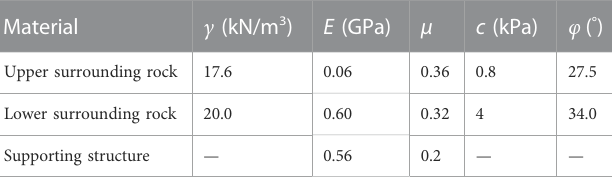
TABLE 1Mechanical parameters ofmodel materials for thesurroundingrock and supporting structure.